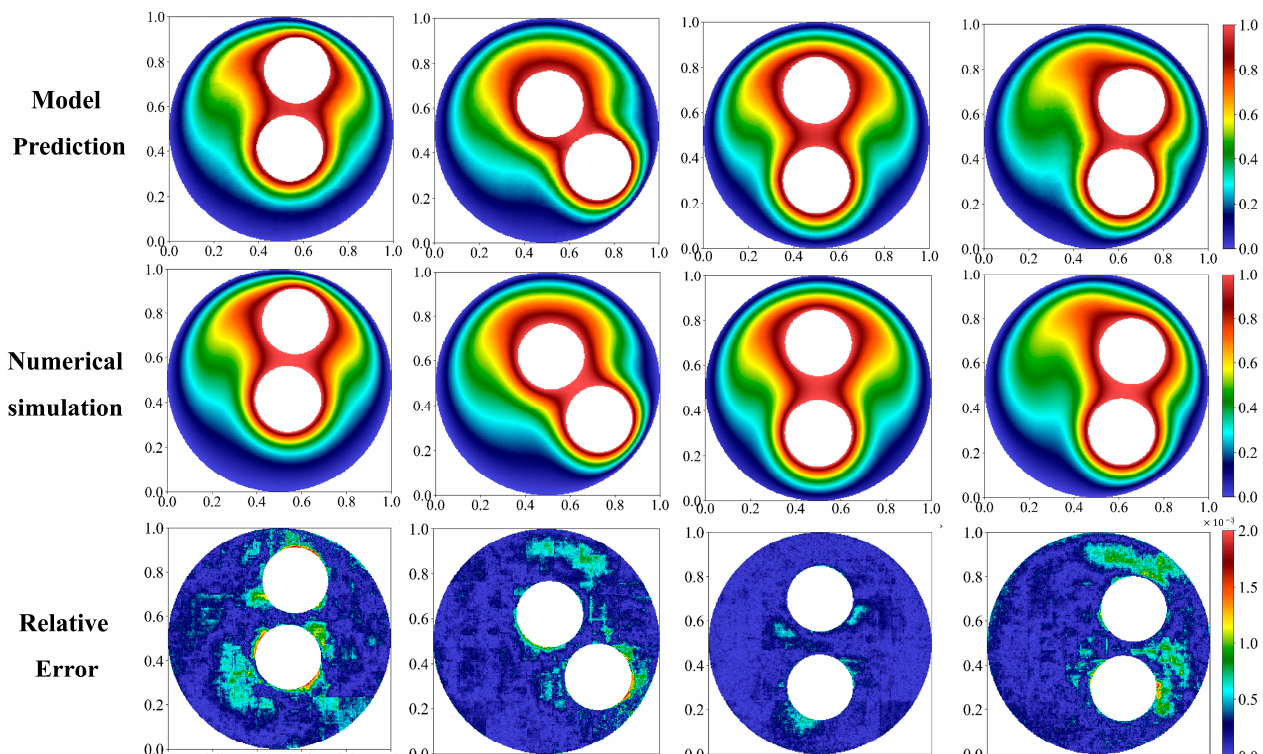
Figure 4. Temperature field predictions of four representative double inner-cylinder annulus with various positions of inner